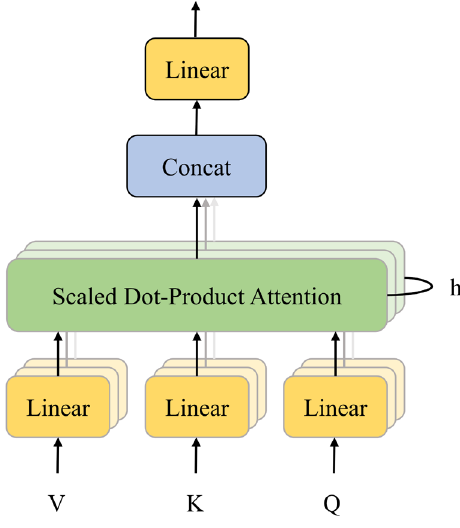
Figure 6. Structure of multi-headed attention mechanism.